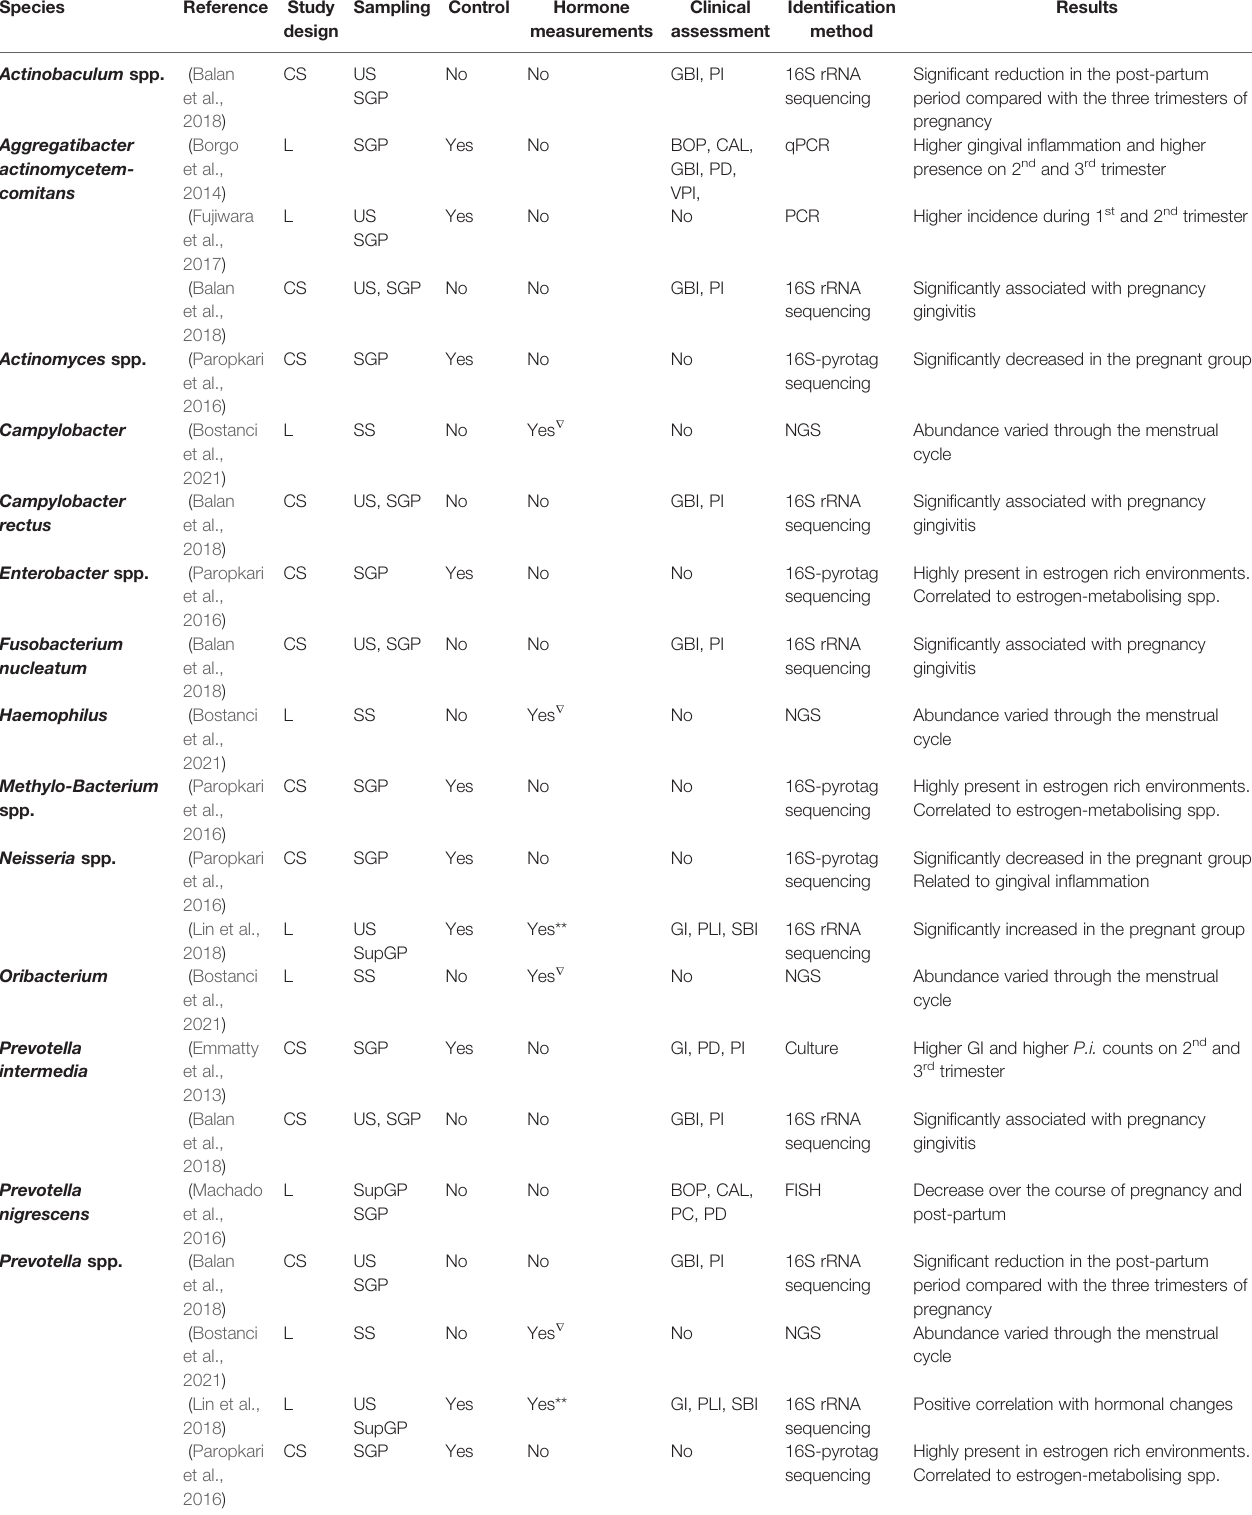
TABLE 2 | Bacteria and fungi affected by the menstrual cycle, pregnancy and postpartum [Not included in (Kumar,